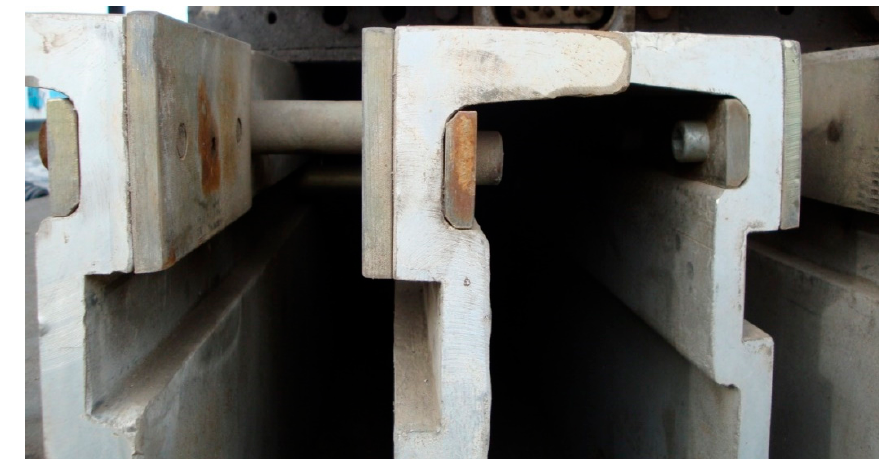
Figure 9. Arrangement of stiffening plates on the free ends of the crossbeams.